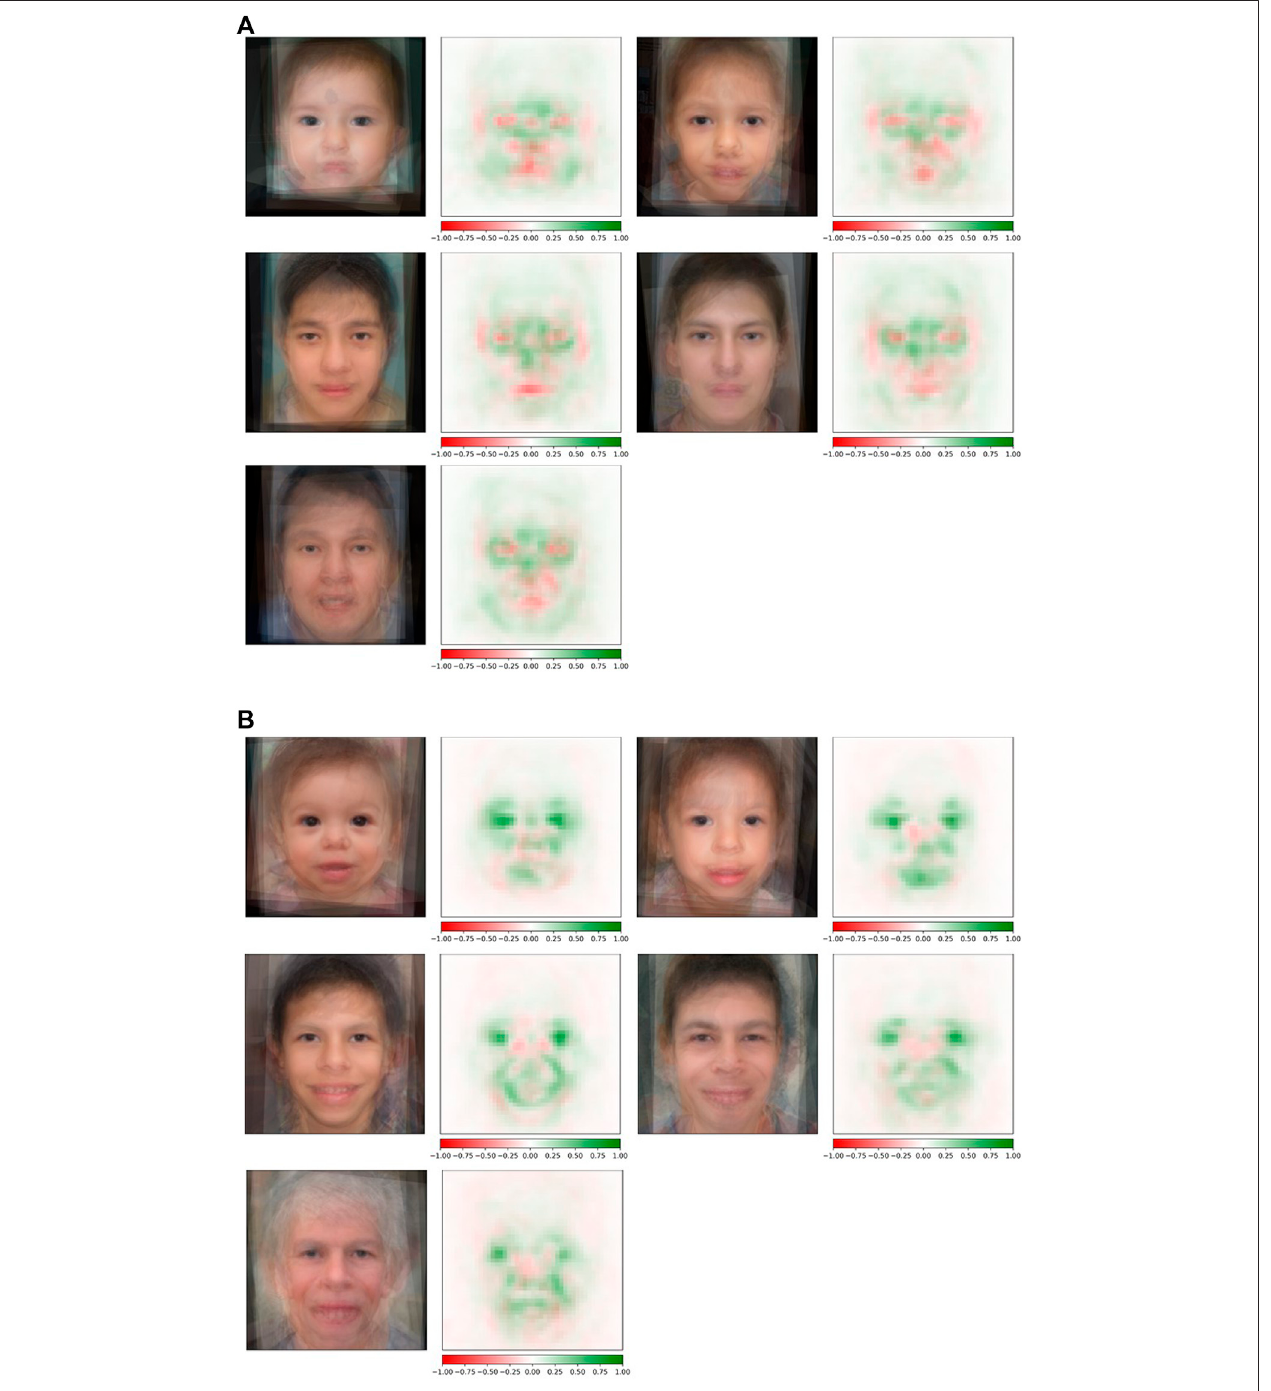
FIGURE4| Occlusionanalysisof22qandWSfacialimagesacrossthelifespan.Compositesaliencymapsweremadebyaveragingoverallthetestimagesineach age group: infant, child, adolescent, young adult, and older adult (reading left to right) for both 22q (A) and WS (B) . Green indicates positive contribution, and red indicates negative contribution to the correct label. For 22q, speci fi c regions of interest (e.g., periorbital regions, glabella, nasal bridge, and the mandible) subjectively appear to be consistently important at all ages analyzed. However, there appear to be some areas that are more speci fi c for people in certain age groups, such as the areas superior to the lateral mandibular region in the youngest age group. Additionally, the periorbital region and nasal root appear to be more important in older age groups. For WS, facial features of interest across all age categories include the eyes (possibly due to the stellate iris or other important ocular features; we note that this pattern was not seen in people with 22q) and the mouth. Our composite WS images suggest that as aging progresses, the positive attribution present during infancy in the nasal root and periorbital region, as well as the eyes to some degree, decreases through older adulthood.